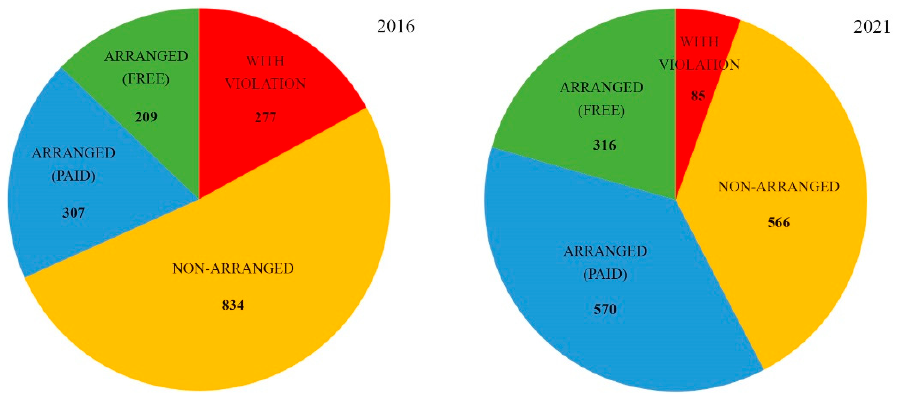
Figure 9. Comparative analysis of changes in on-street parking—field survey (2016 and 2021).